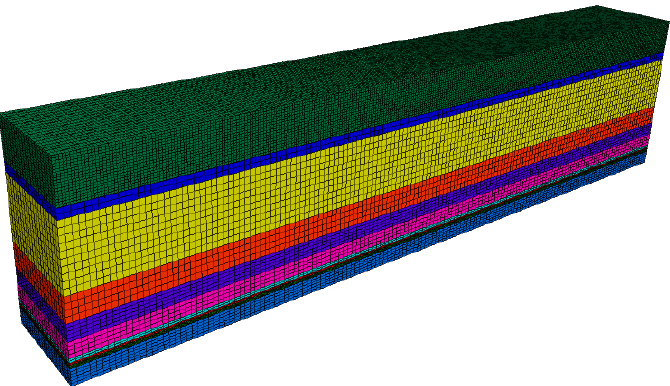
Figure 6. Thick coal seam gangue-filling mining model.